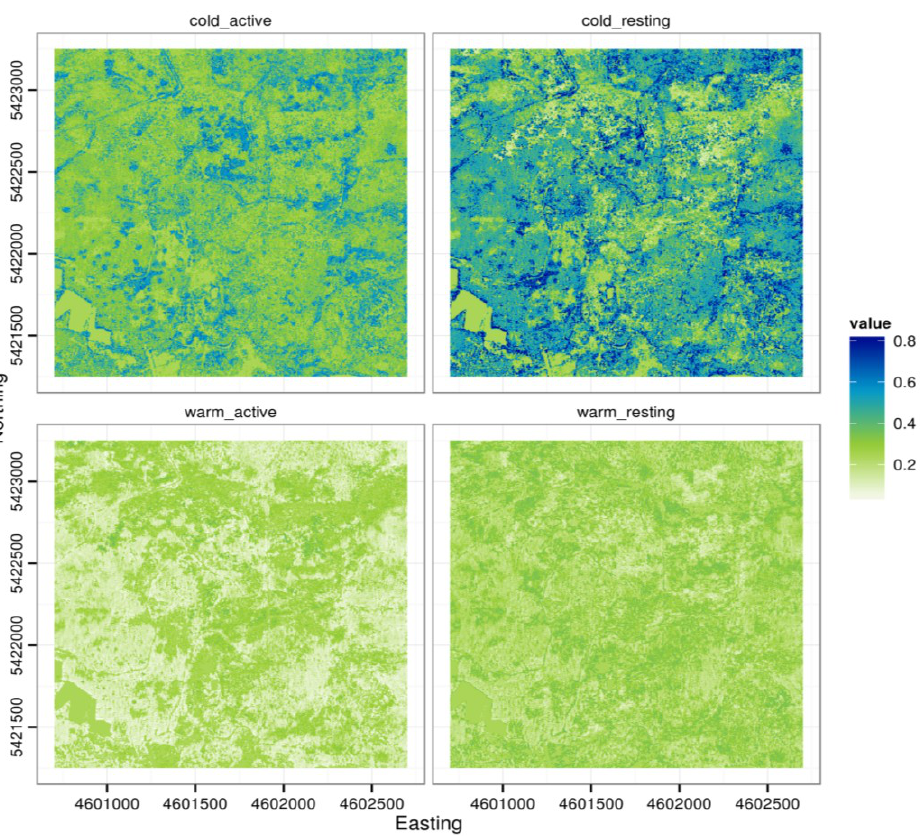
Figure 6. Maps showing predicted values of roe deer habitat preference for different scenarios of weather conditions and activity status; prediction maps where calculated using model 1 (Table 2), keeping the distance to the nearest feeding place constant at the dataset mean; cold_active: prediction for active roe deer at temperatures kept constant at the 10th percentile and snow height kept constant at the 90th percentile of observed values; cold_resting: resting roe deer, 10th percentile temperature value, 90th percentile snow height value; warm_active: active roe deer, 90th percentile temperature value, no snow; warm_resting: resting roe deer, 90th percentile temperature value, no snow. Map projection: DHDN, Gauss-Krüger Zone